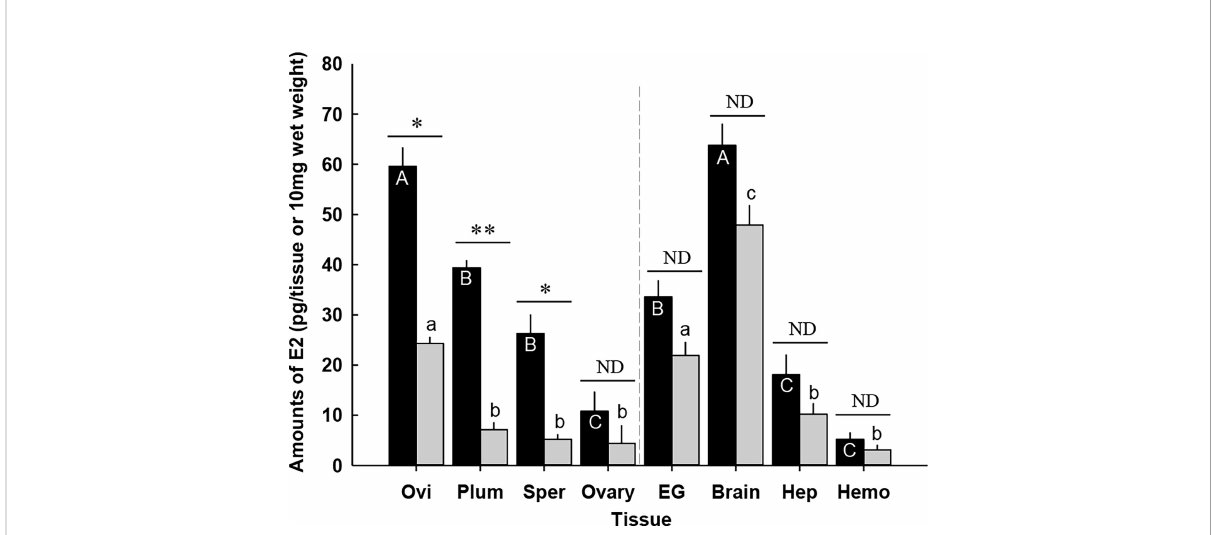
FIGURE 9 Amounts of 17 b -estradiol (E2) in the tissues of the adult female C. sapidus at ovarian stage 2 (black bar: saline-injected group; grey bar: CFSH- dsRNA-injected group). Results are presented as the mean ± 1SE pg/EG, brain or 10 mg wet weight ( n = 5). The data are analyzed two ways for statistical signi fi cance: Student ’ s t-test was calculated when two groups were compared. A non-parametric Kruskal-Wallis test followed by Dunn ’ s post-hoc test was used for multiple group comparisons (letter or * p < 0.05; ** p < 0.01; nd, no difference). Ovi, ovigerous setae; Plum, plumose setae; Sper, spermathecae; EG eyestalk ganglia; Hep, hepatopancreas and Hemo,